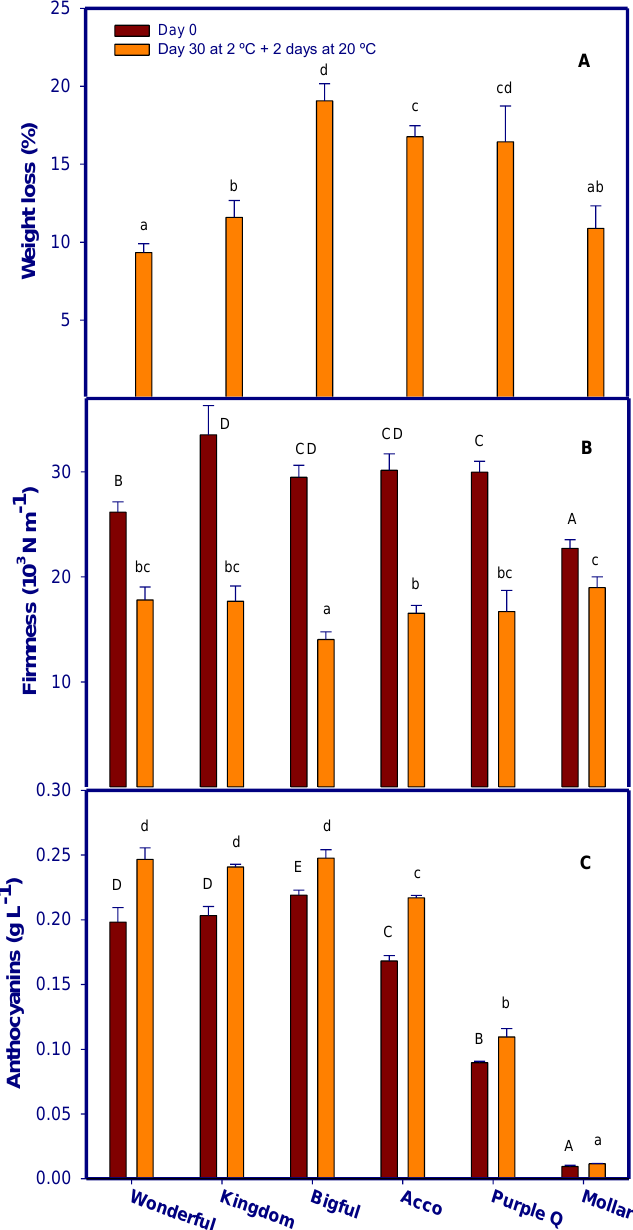
Figure 4. Weight loss ( A ), firmness of whole fruit ( B ) and total anthocyanins ( C ) of pomegranate cultivars at harvest (red bar) and after storage for 30 d at 2 °C plus 2 d at 20 °C (orange bar). Different tailored letters show significant differences ( p < 0.05) between data at harvest. Different lowercase letters show significant differences ( p < 0.05) between data after storage for 30 d at 2 °C plus 2 d at 20 °C. Data are the mean ± S.E. of determinations made in 3 replicates of 10 fruit. TSS content (Table 4) at harvest was in the range 13.28–16.10% in the different cultivars. ‘Mollar de Elche’, ‘Kingdom’, and ‘Wonderful’ cultivars showed the highest (>15), TSS concentration at harvest, 15.83 ± 0.72, 16.10 ± 0.13%, and 16.03 ± 0.16% respectively, ‘Acco’ and ‘Bigful’ had a TSS content of 14.23 ± 0.18% and 14.18 ± 0.15%, respectively, while ‘Purple Queen’ had 13.28 ± 0.09% of TSS. During storage, TSS did not change in ‘Mollar de Elche’, ‘Kingdom’, ‘Wonderful’, and ‘Bigful’ cultivars, while in ‘Acco’ and ‘Purple Queen’ it decreased. Sucrose, glucose, and fructose were the three sugars identified in all cultivars (Table 4). Sucrose concentration was lower than 0.7 g L − 1 (accounting for 1% of total